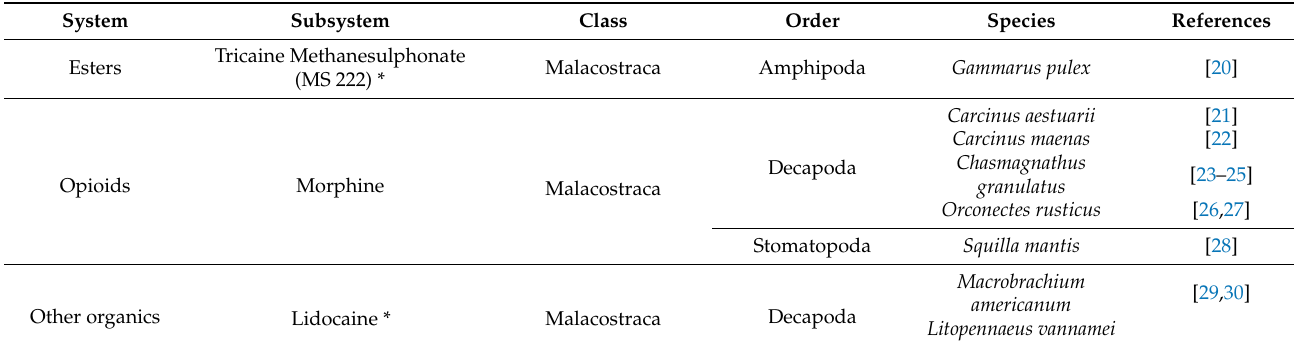
Table 1. List of analgesics used in